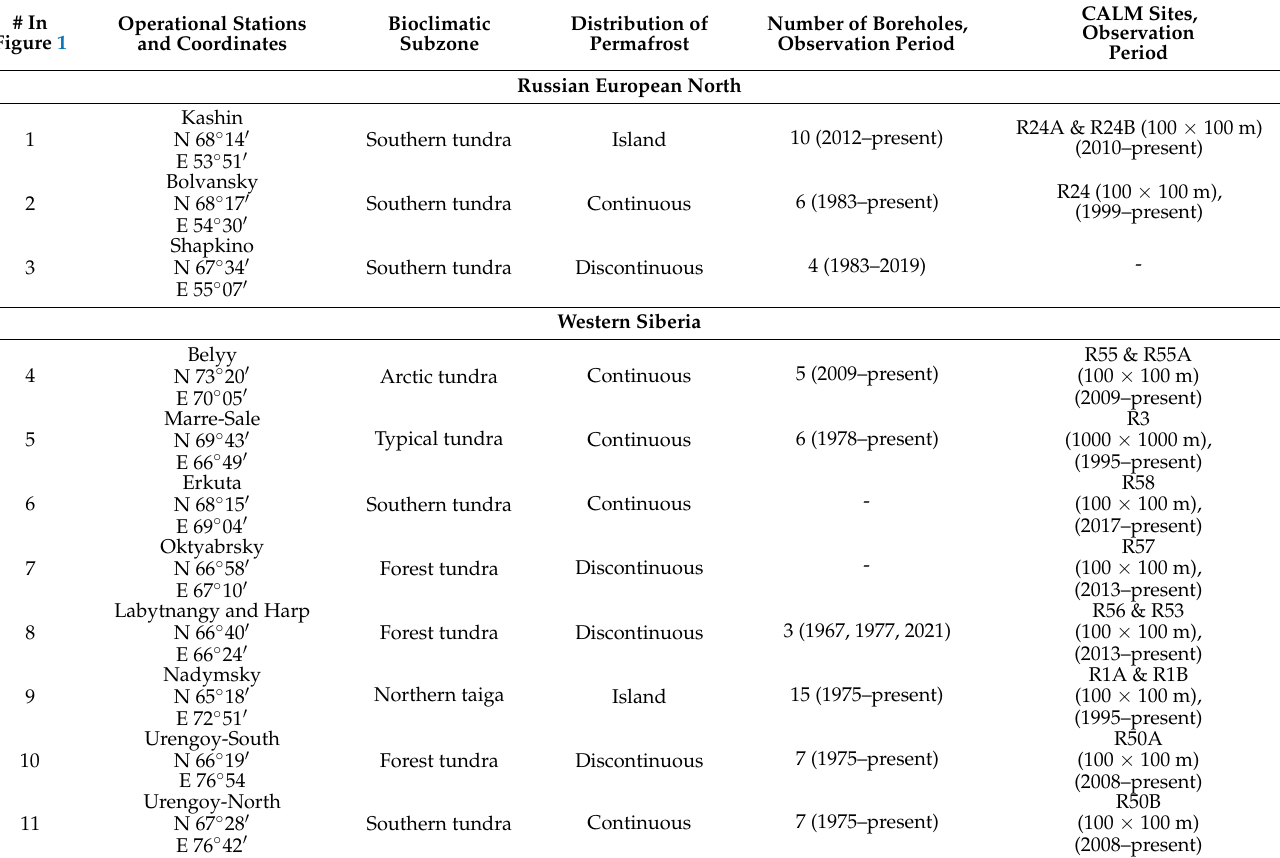
Table 1. Metadata of monitoring observations in the western sector of the Russian